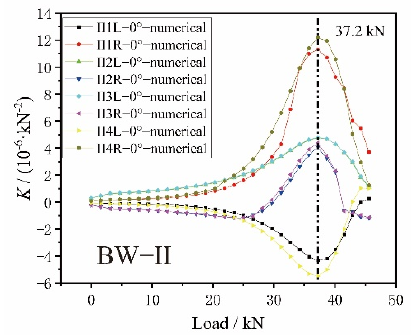
Figure 31. The numerical K-load curves of the different strain measurement points for the composite beam of BW-II.